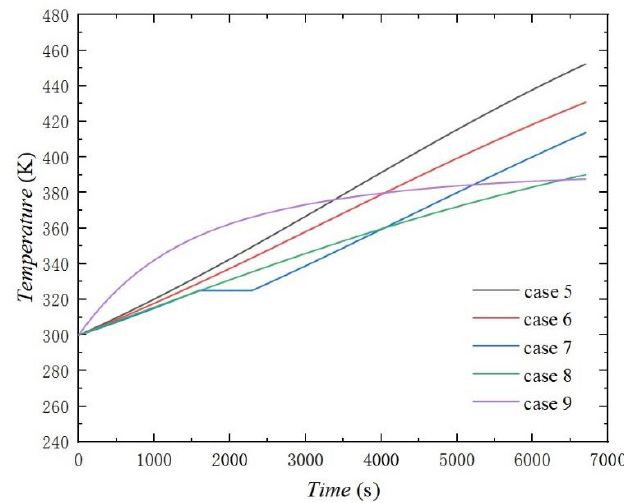
Figure 19. Temperature of accessory 2 when the casing and accessory were thermally protected.